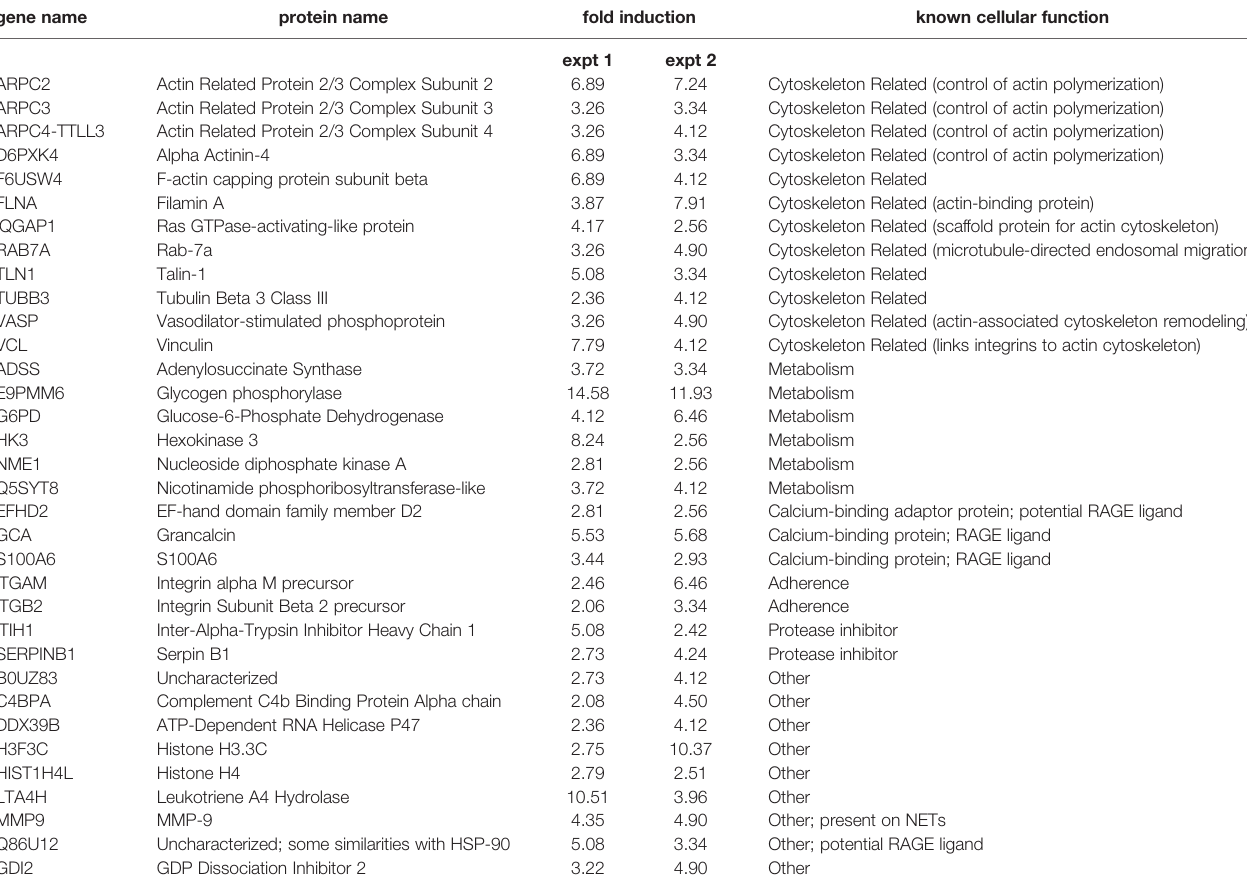
TABLE 1 | Common proteins featuring featuring at least a 2-fold induction (TNF vs unstimulated), in two independent